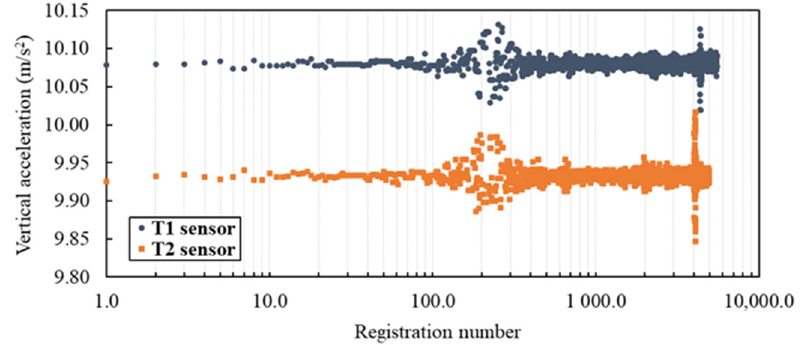
Figure 5. Non-adjusted vertical accelerations by T1 and T2 sensor.